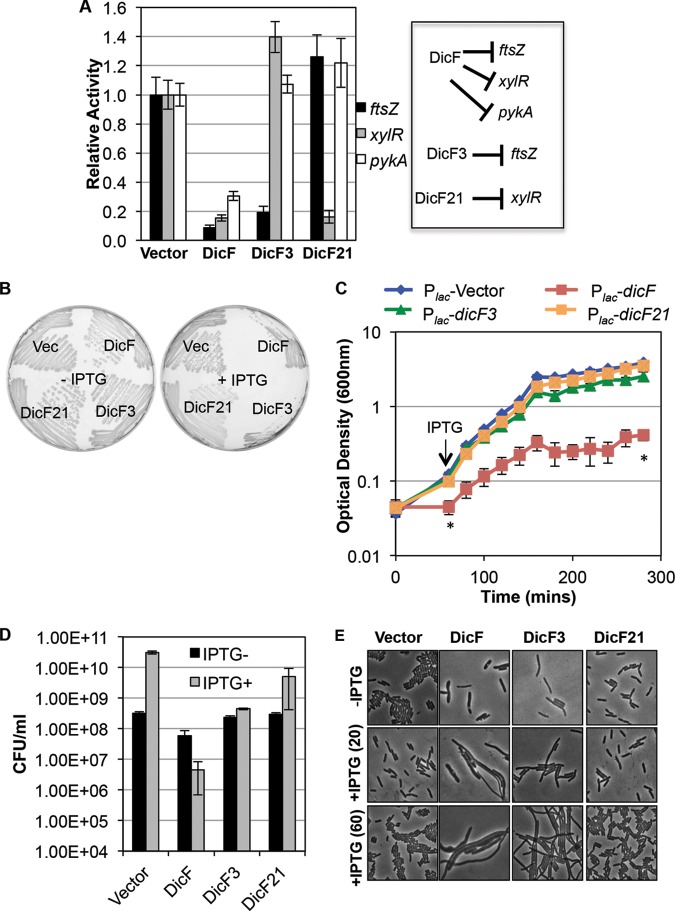
DicF inhibits cell division and prevents biomass increases. (A) The strains with xylR′, pykA′, and ftsZ′-′lacZ fusions and plasmids containing dicF, dicF3, or dicF21 were assayed for β-galactosidase activity, after induction of the dicF alleles. A schematic representing regulation of the various targets by DicF and the mutants is on the right. (B) ΔdicF lacIq strains carrying either the vector control or the dicF alleles shown in the figure were streaked on LB plates with and without 0.5 mM IPTG. (C) ΔdicF lacIq strains carrying either the vector control or various dicF alleles was grown, 0.5 mM IPTG was added to the cultures, and growth was monitored over time. (D) The viability of the strains described for panel C was measured at time points indicated by asterisks. (E) Phase-contrast images of strains described for panel C imaged before (-IPTG) and 20 min [+IPTG (20)] and 60 min [+IPTG (60)] after addition of 0.5 mM IPTG.